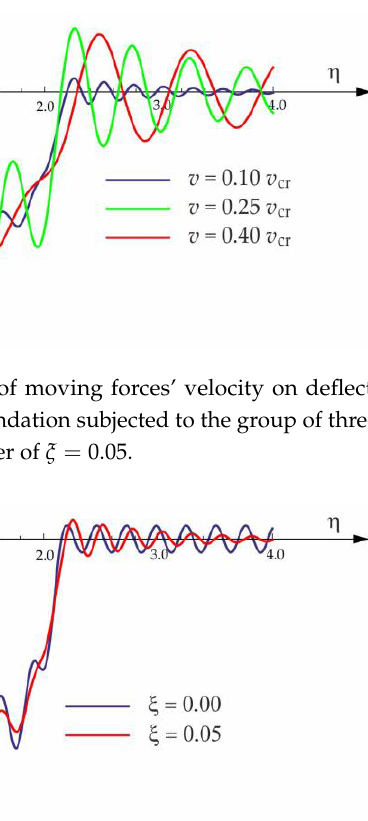
Figure 15. Vibration of midpoint of the beam on three-parameter Vlasov foundation subjected to one force, two forces, and three forces moving at a speed of v = 50 m/s, a distance of a = 3 m, and a damping number of ξ = 0.05.